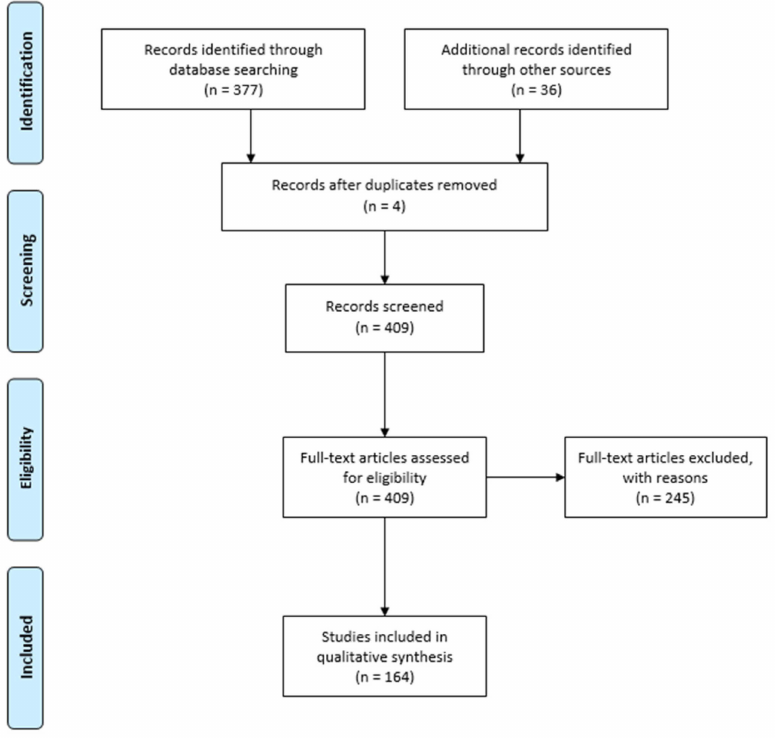
Figure 2. Overview of studies identified in the steps of the systematic review process derived from the PRISMA flow diagram (Source: Moher D, Liberati A, Tetzlaff J, Altman DG, The PRISMA Group,